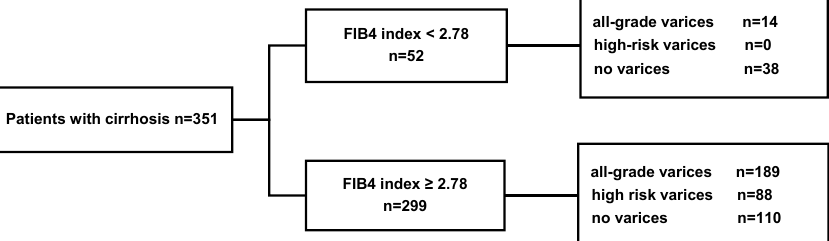
Figure 3. Rates of all-grade varices and high-risk varices according to a FIB-4 cutoff of 2.78 in the validation cohort of patients with cirrhosis. EV, esophagealvarices; FIB-4, fibrosis index based on four factors.